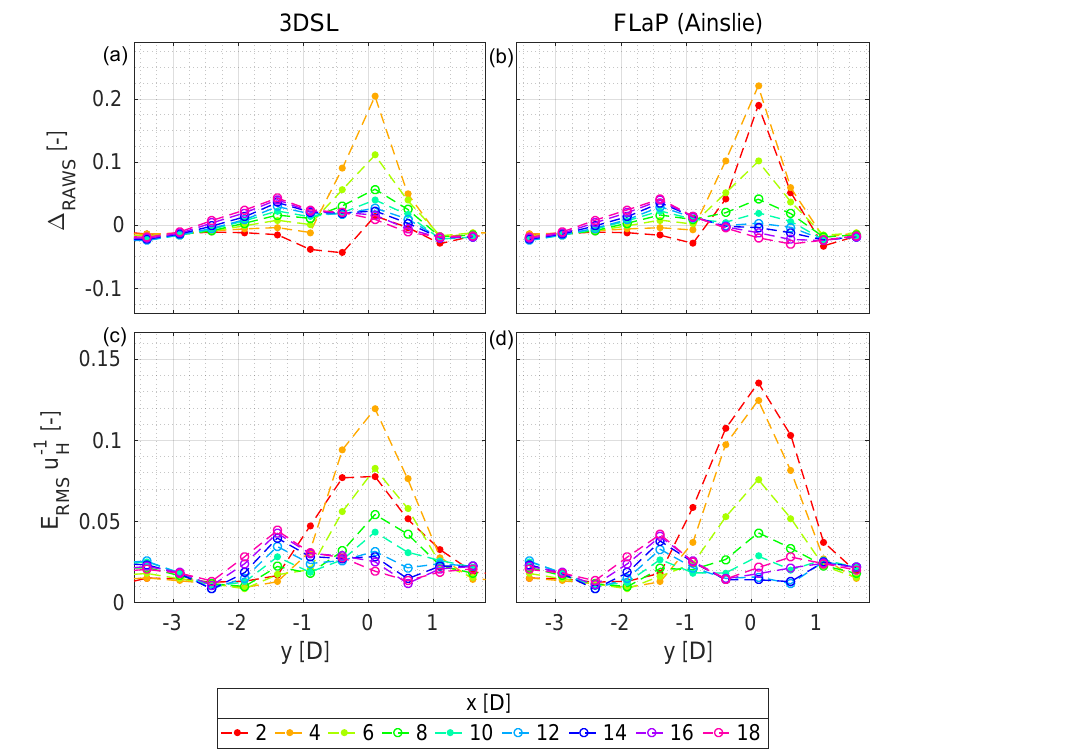
Figure 5. Test case 1 (single wake). Deviation of the rotor-average wind speed (cid:49) RAWS (a, b) and of the root mean square error E RMS (c, d) evaluated in relation to the large-eddy simulation wind field for the simulation with the 3DSL model and with FLaP.